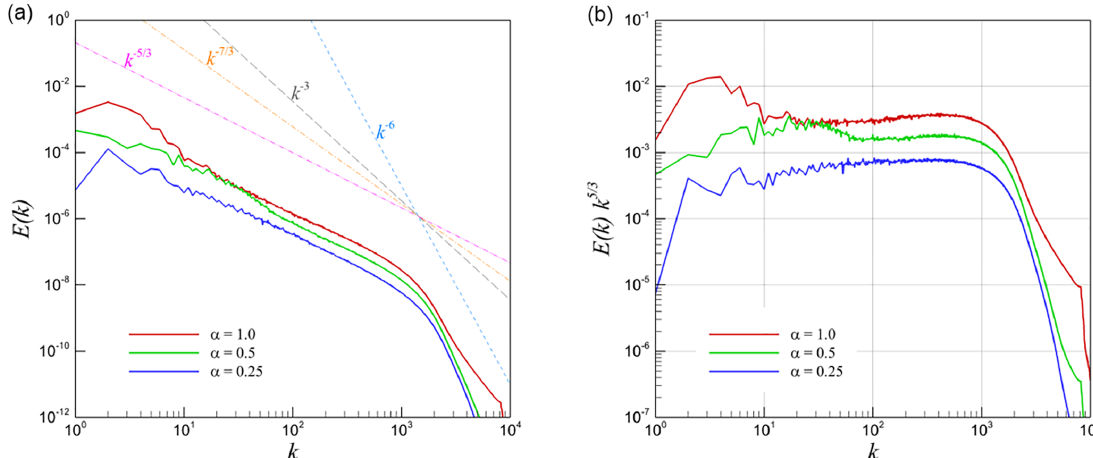
Figure 14. The difference spectra for 2-D KHI turbulence. (a) Difference spectra between the kinetic velocity field and the normalized density-weighted velocity field (i.e., E(k) is obtained from the g = u